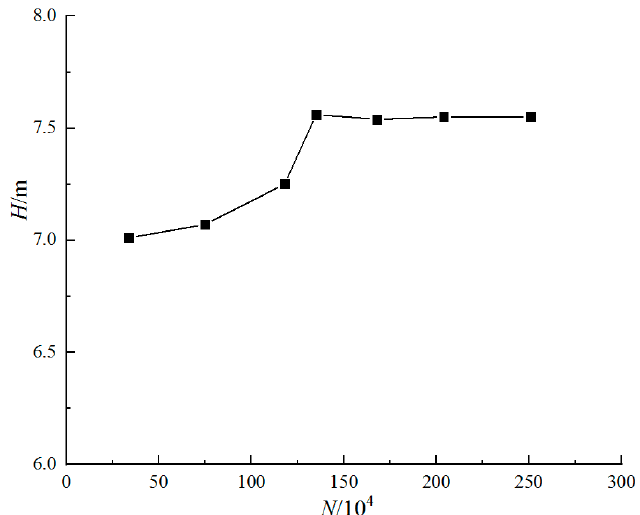
Figure 5. Analysis of grid independence.